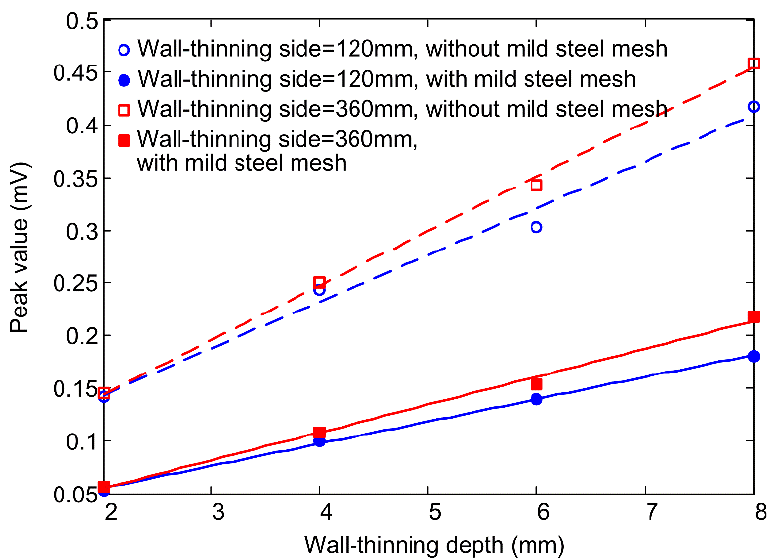
Figure 8. Relationship between the signal peak value and wall-thinning depth for square wall thin- nings of 120 mm and 360 mm long sides when the mild steel mesh is absent and present, respec- tively.